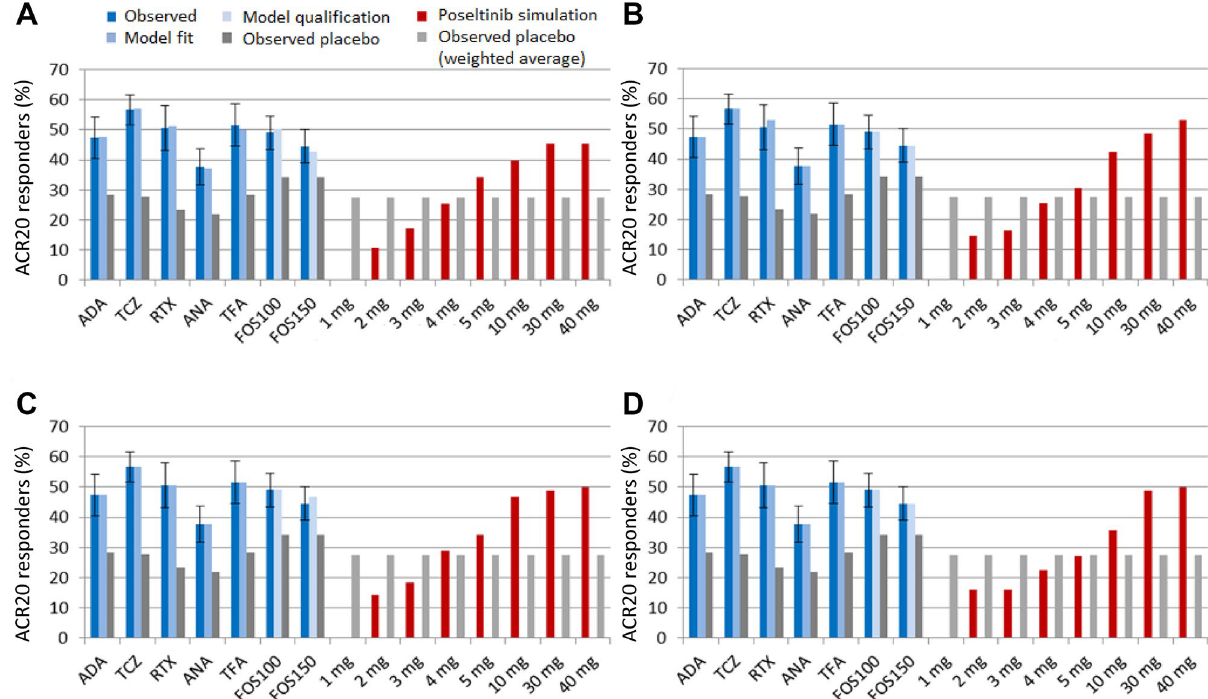
Figure 8. Simulated clinical efficacy (ACR20 responders, %) of poseltinib. Virtual populations in a QSP model for RA were fit to observed clinical trial data (dark blue) for therapeutics with different mechanisms of